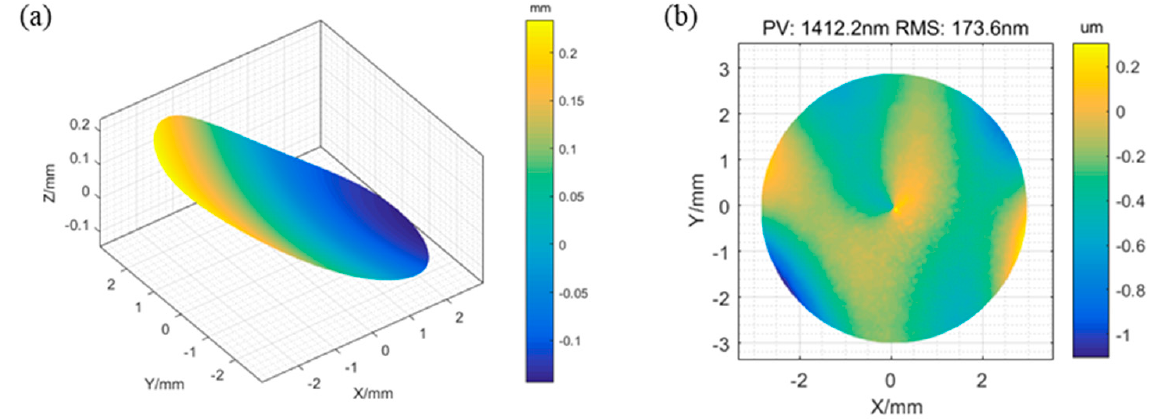
Figure 6. Freeform surface measured after first machining ( a ) and ( b ) the corresponding form error.